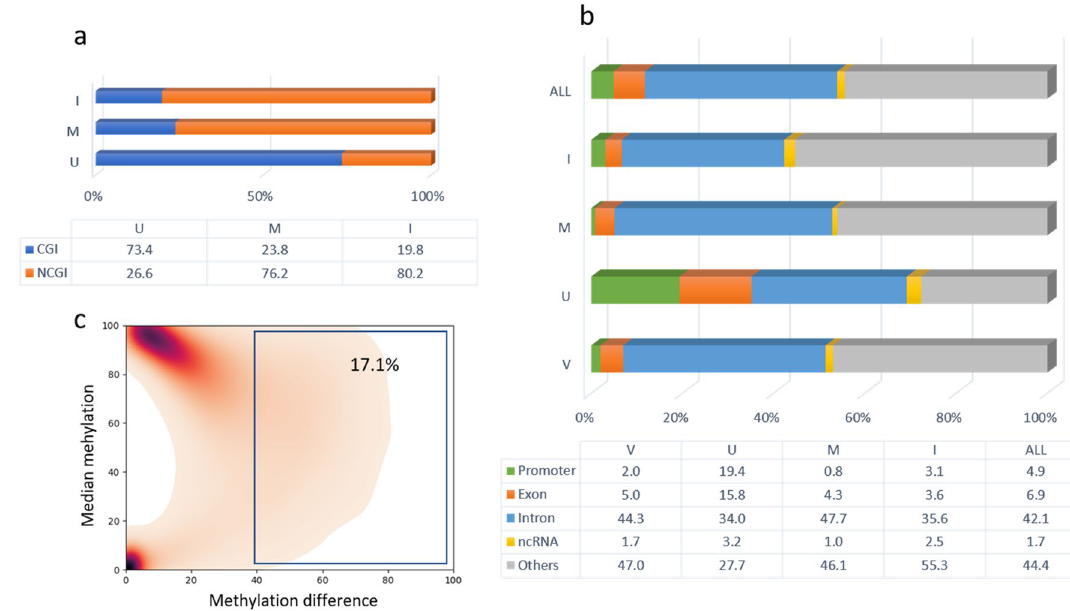
Figure 4. Percentage of constitutively unmethylated (U), methylated (M), and intermediately methylated (I) CpGs analyzed in this study in each category of ( a ) CpG islands and ( b ) genomic features. ( c ) Density scatterplot of CpG-wise DNA methylation level differences (x axis) and CpG median methylation (y axis) across the 32 samples depicted by seaborn (https:// doi. org/ 10. 5281/ zenodo. 592845). Coloring indicates CpG density from low (sparse) to high (dense). The blue box highlights variable CpG